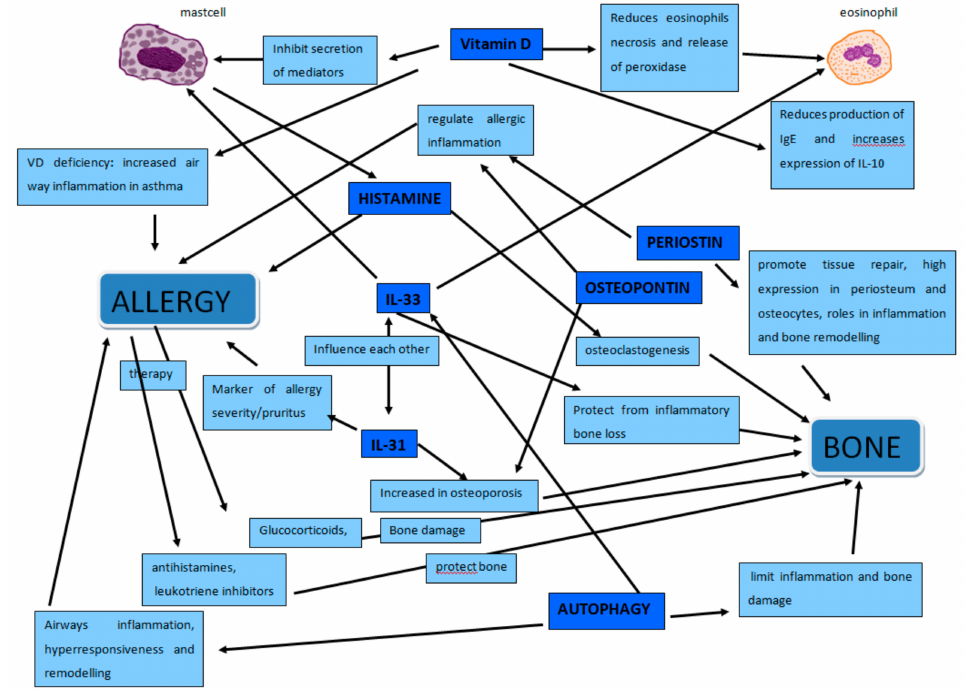
Figure 2. The figure shows the complex network of relationships between allergy and bone. Mast cells that play a leading role in allergy but also in the regulation of bone metabolism through histamine, tryptase and other molecules. Osteopontin that regulate allergic inflammation and increase in osteoporosis. Periostin that regulate allergic inflammation and intervene in bone remodelling. IL-31 marker of allergic inflammation that increases in osteoporosis. IL-33 that influences both mast cells and eosinophils, modulate allergic inflammation and protect from inflammatory bone loss. Vitamin D, regulator of calcium / phosphate balance, recognized immunomodulatory agent, that inhibit secretion of mediators by mast cells, reduces eosinophils necrosis, release of peroxidase, production of IgE and increases expression of IL-10. Autophagy that regulate IL-33, in osteoimmunology limit inflammation and bone damage while in asthma contribute to airways inflammation, hyperresponsiveness and